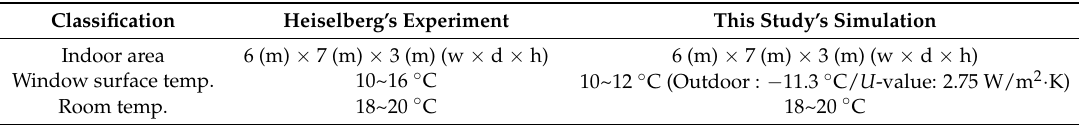
Table 5. Simulation implementation condition in the Heiselberg’s experiment and this study.